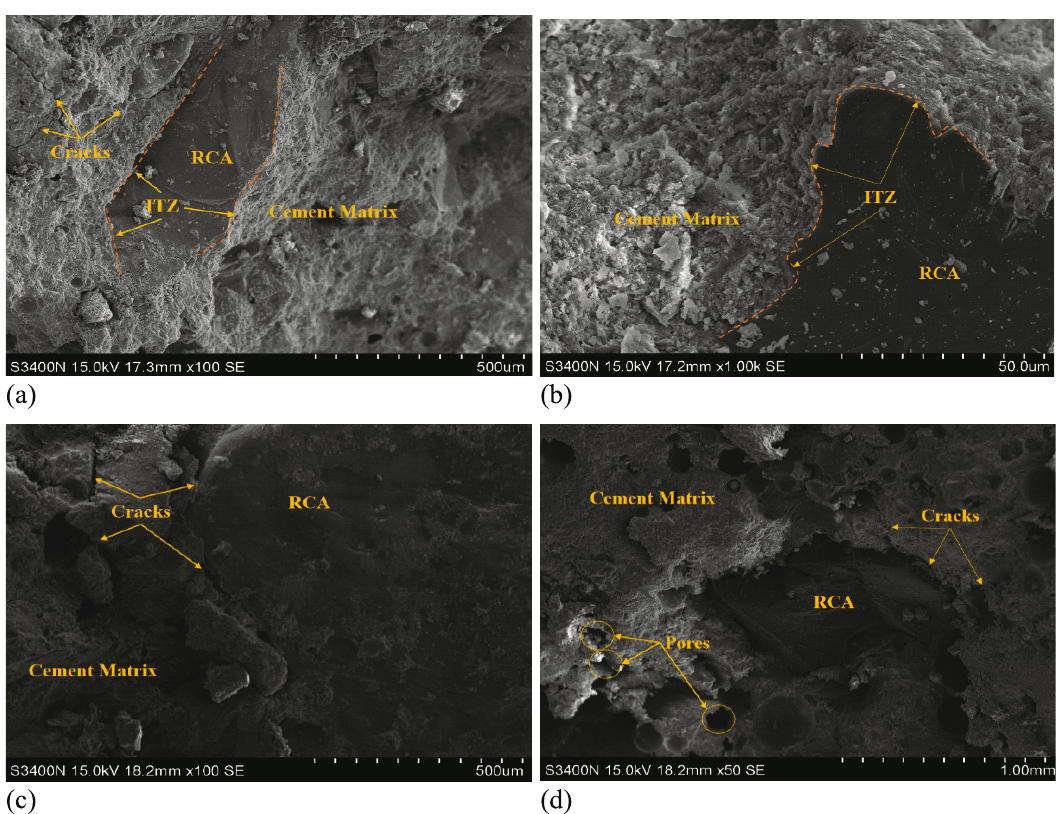
Figure 22: Comparison of microstructures of RRAC with and without RCA modi fi cation treatment: ( a and b ) with AM treatment and ( c and d ) without AM treatment.